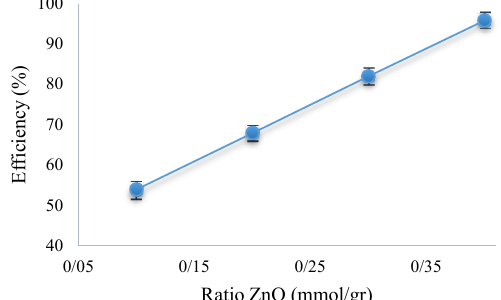
Fig. 7. Effect of changes in initial concentration of ZnO to activated carbon in removal of acid blue 113 dye (pH: 3, initial dye concentration: 100 mg/l, modified photocatalyst concentration: 100 mg/l, reaction time: 30 minutes)